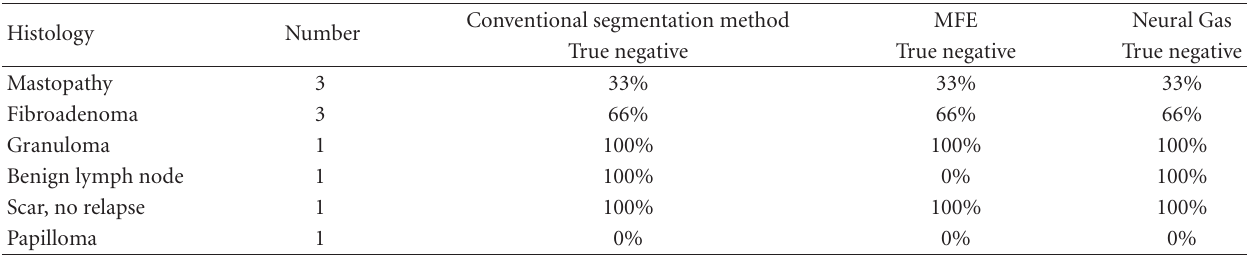
Table 4: Comparison of the conventional segmentation method and minimal free energy vector quantization and “neural-gas” network in the detection of benign lesions.